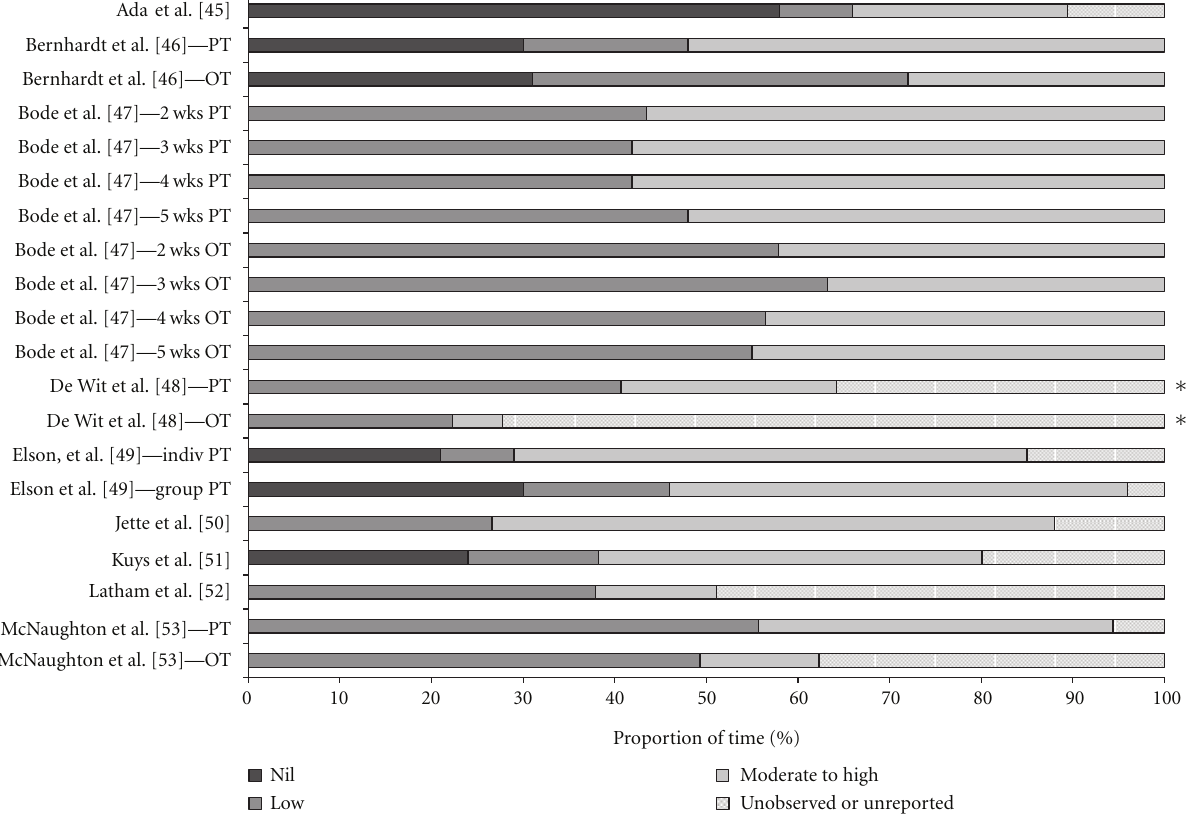
Figure 5: Therapy activity. ∗ Data pooled across sites by authors of original study.